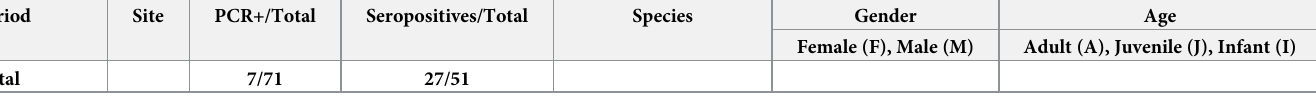
Free nuclease water was used as negative control. Reverse transcriptase PCR products were visualized using a 2% agarose gel electrophoresis stained with Gel Red. Samples that showed bands with the expected size (DENV1: 482bp, DENV2: 119bp, DENV3: 290bp, DENV4: 392bp, WNV: 400bp) were considered positive.